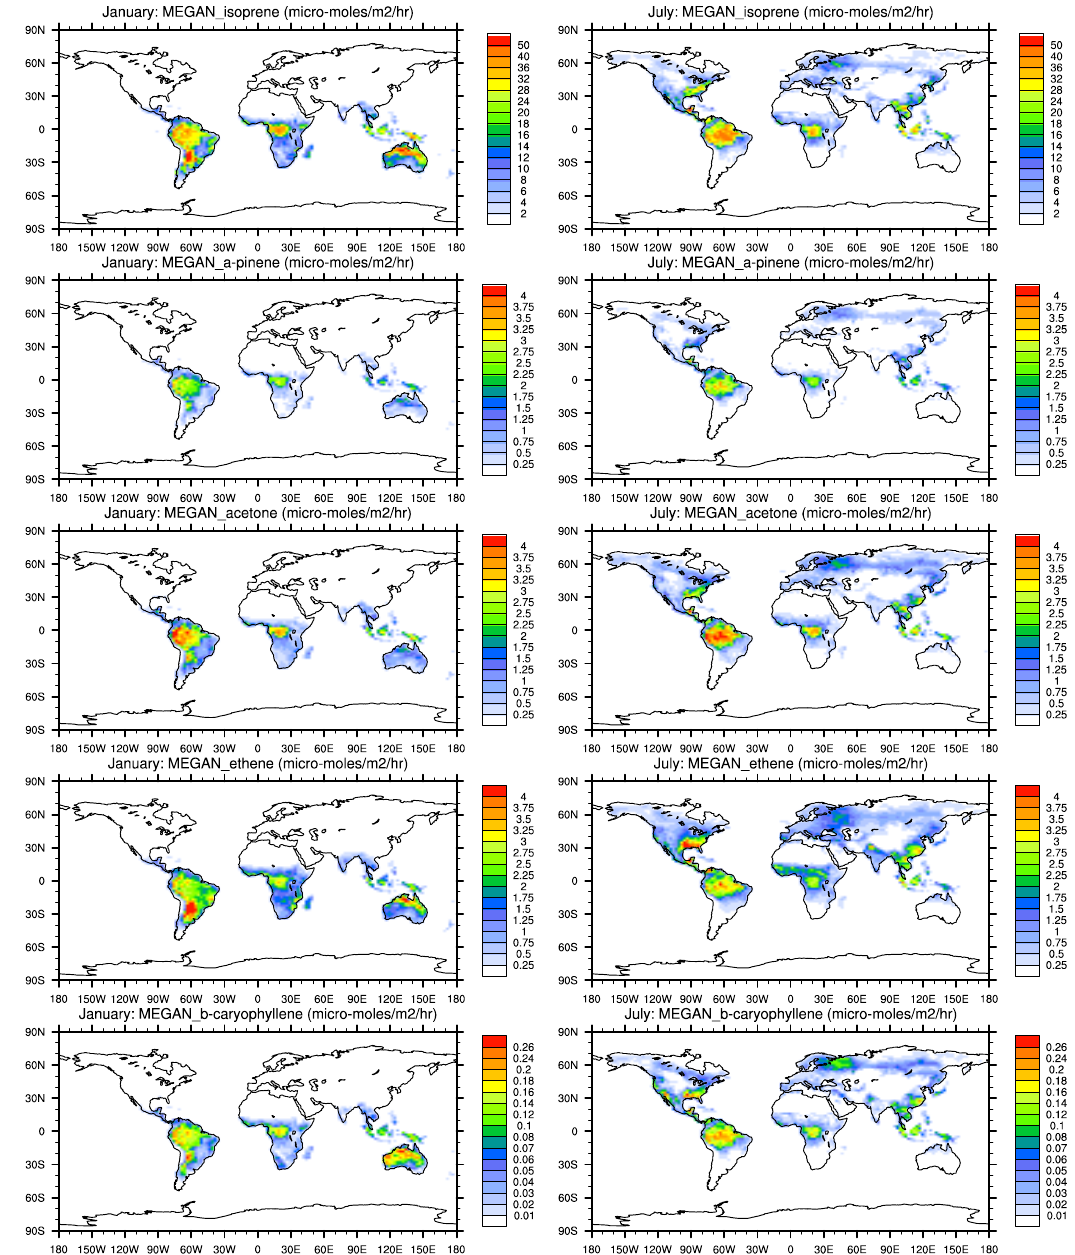
Fig. 3. January and July 2000 global emissions of isoprene, α -pinene, acetone, ethene and β -caryophyllene simulated with MEGAN 2.1 Figure 3: January and July 2000 global emissions of isoprene,  -pinene, acetone, ethene algorithms using and  -caryophyllene simulated with MEGAN 2.1 algorithms using CLM4.